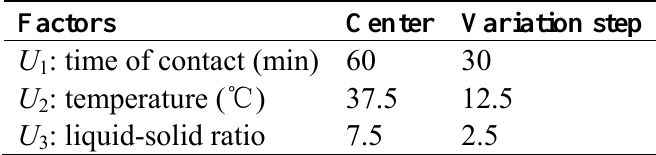
Table 1. Experimental domain for the three studied